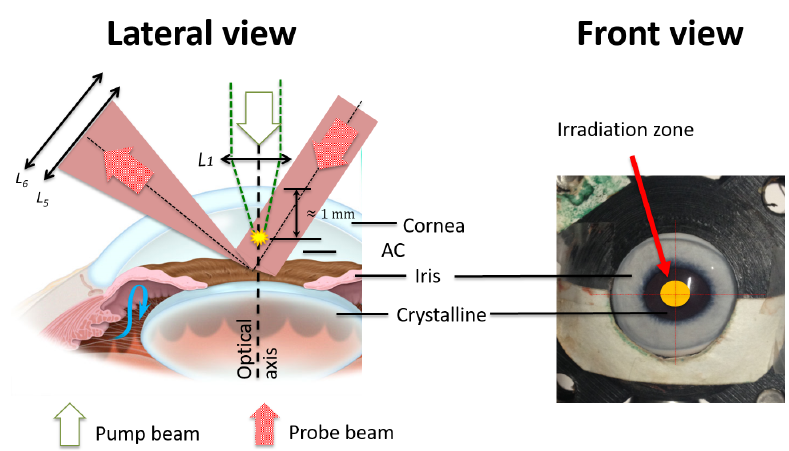
Figure 3. Setup of the STM technique within the anterior chamber (AC). The cavitation bubbles are generated right below the cornea center 1 mm within the AC. The scattered probe beam is collected by a lens system to send the transmitted light onto a